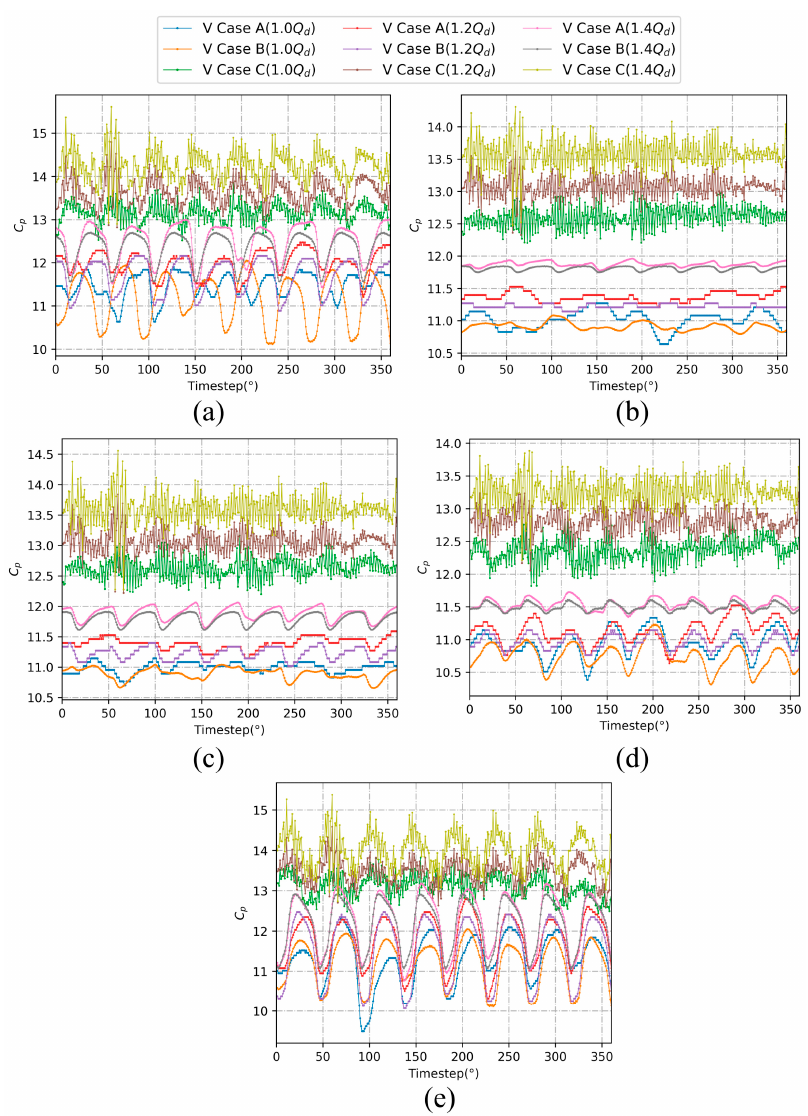
Figure 16. Time-domain of pressure fluctuations at different monitoring points within the volute of the three optimized impeller cases at the locations of: ( a ) V1, ( b ) V2, ( c ) V3, ( d ) V4 and ( e ) V5. In the volute flow passage, the pressure fluctuation at monitoring points “V1”–“V5” had quite similar trends in all the optimized cases A, B and C. Within the volute flow passage, monitoring